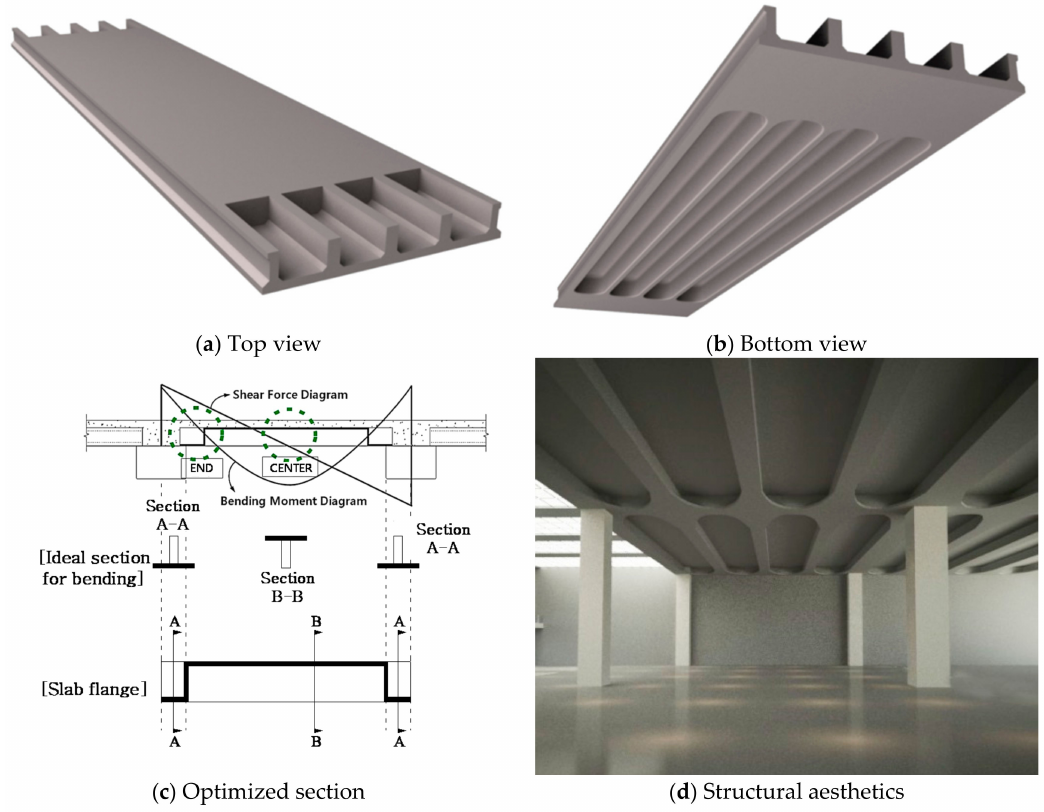
Figure 1. Concept of an optimized-section precast slab with structural aesthetics